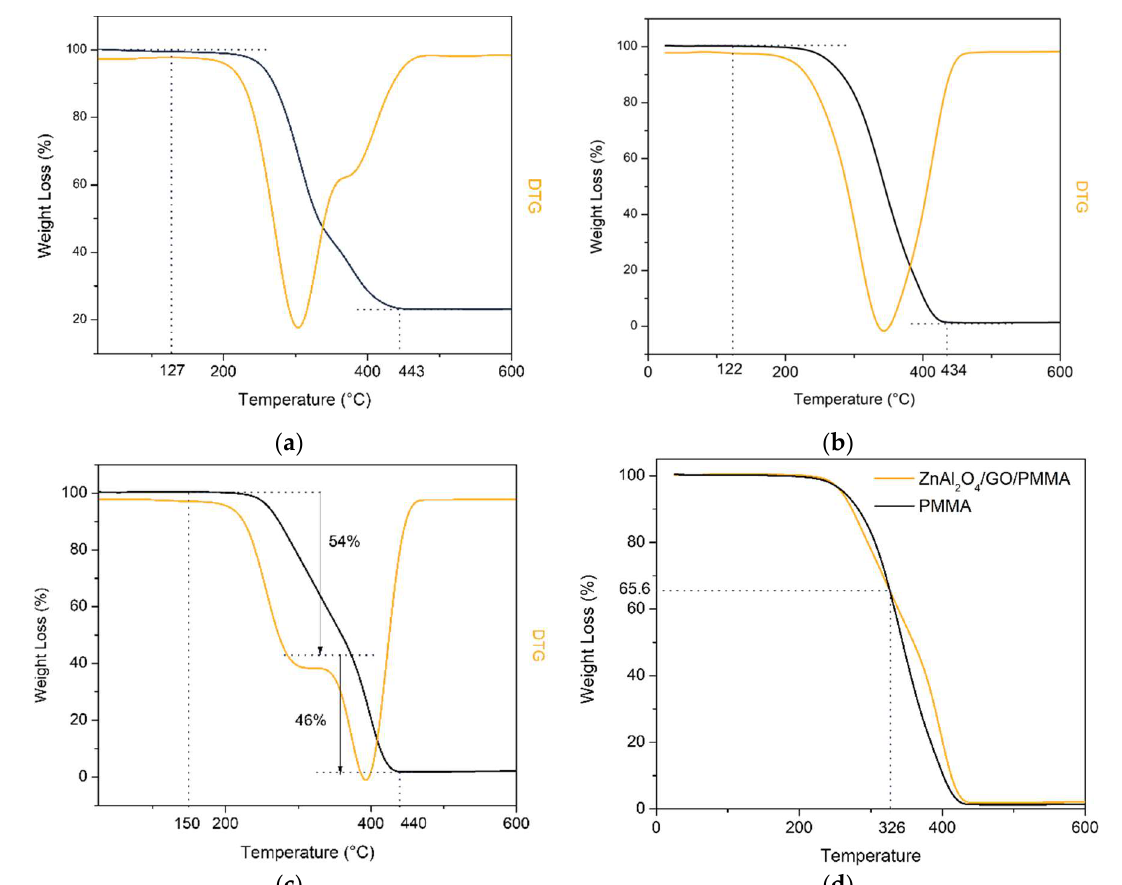
Figure 7. TG of ( a ) ZnAl 2 O 4 : Mn/GO-Br, ( b ) PMMA; ( c ) ZnAl 2 O 4 : Mn/GO/PMMA; ( d ) ZnAl 2 O 4 : Mn/GO/PMMA and PMMA.